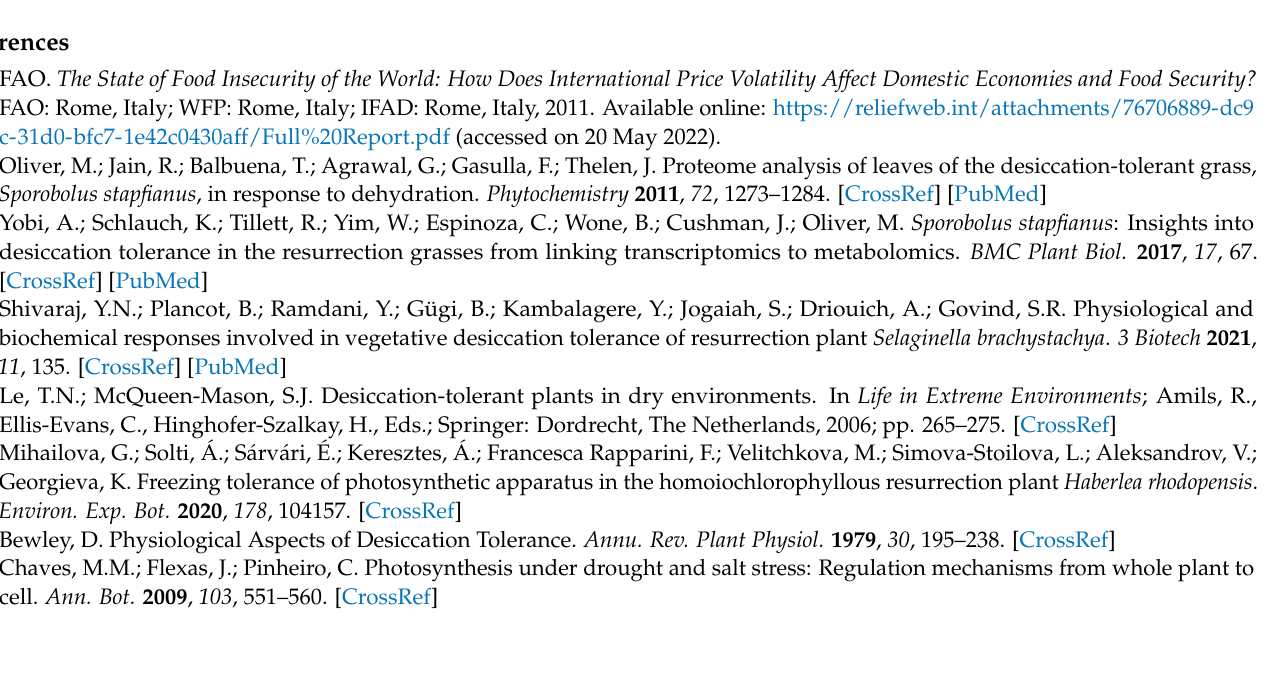
Figure S3: Representative Western blots of the main thylakoid-related proteins of Haberlea rhodopensis during the recovery from drought- (RAD) and freezing-induced desiccation (RAF); Figure S4: In-gel activity staining of protease bands at pH 6.0 and pH 8.5 during the first hours of RAD and RAF; Figure S5: Multiple alignment of ELI_PEA protein (acc. No SP:P11432) with the translated open reading frames (ORFs) encoded by the ELIP encoding contigs, identified by the BLAST search [85]; Figure S6: Expression heat map of the identified contigs, encoding ELIP proteins under